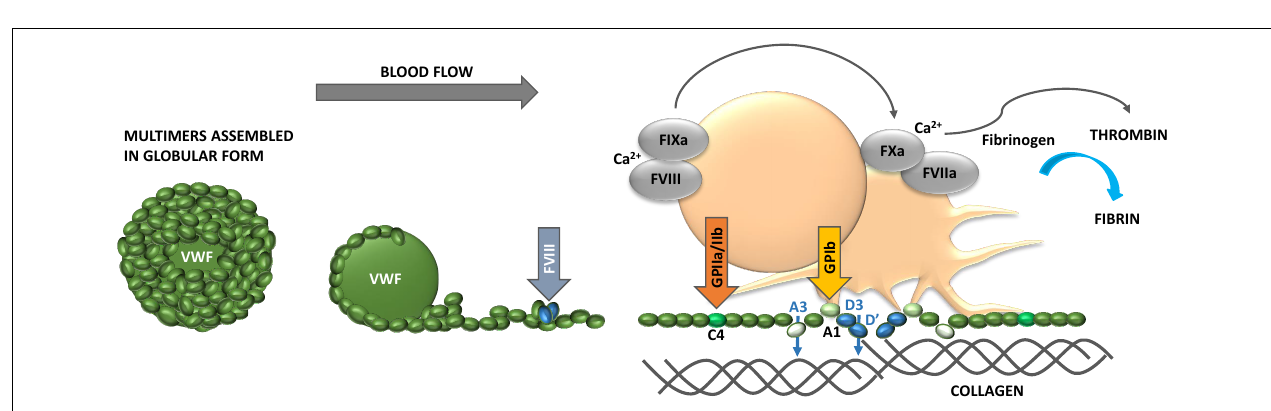
FIGURE 1 | Role of endothelial glycocalyx and platelets in vascular injury. Glycocalyx lines the vascular endothelial cell surface facing the vessel lumen forming a barrier between blood and endothelium maintaining the steady state, but also protects vasculature from pathogens. Glycocalyx supports anticoagulation by enhancing the natural anticoagulants antithrombin (AT), tissue factor pathway inhibitor (TFPI), protein C and S. Disruption of the glycocalyx exposes endothelial cell adhesion molecules [endothelial cell intercellular adhesion molecule-1 (ICAM-1), vascular cell adhesion molecule-1 (VCAM-1), and P-selectin] and extracellular matrix components, i.e., von Willebrand factor (VWF), collagen and tissue factor (TF) in a deeper injury (smooth muscle cells, adventitia). These structures capture blood cells, activating the crosstalk between the inflammatory cells and the coagulation system. Activated platelets release heparinase, metalloproteinases and collagenase to progress the local injury. Activation of platelets feeds back further expression of procoagulant P-selectin, platelet factor 4 (PF4), interleukin-1 β (IL-1 β ), and CD40 ligand to foster the thrombo-inflammatory interactions. Enhanced activation of platelets and leukocytes induces neutrophil extracellular traps (NETs) formation, which in turn activates both inflammatory and hemostatic arms. Vascular endothelial injury and related procoagulant and inflammatory activities may be downplayed by replacing the defective glycocalyx structure with glycosaminoglycan (GAG) moieties, such as APAC.